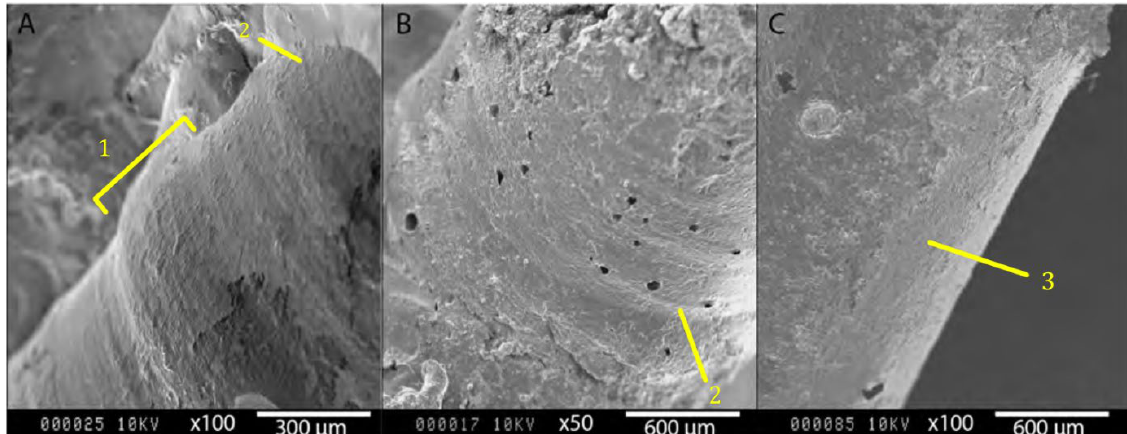
Figure 11: SEM images of the elastomer casts of the GD-01-002 (A), GD-01-005 (B) and GD-01-003 (C) perforations. The pushing marks (1), striations (2) and polished surfaces (3) are shown.